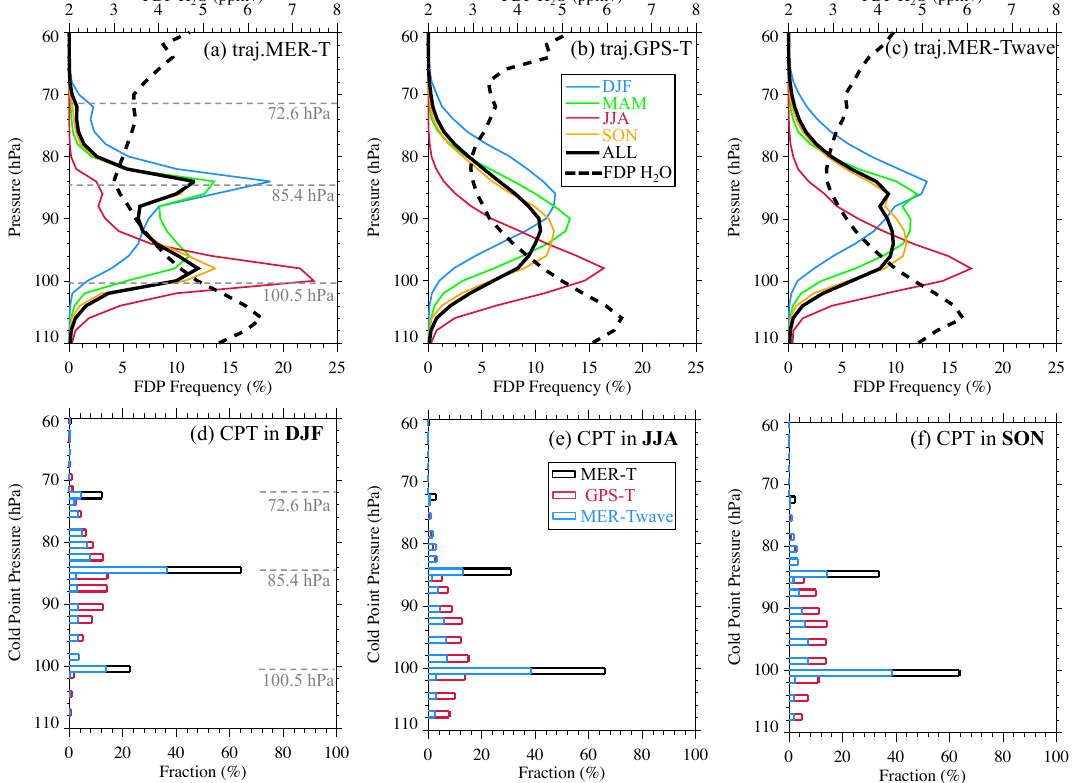
Figure 5. Seasonal FDP vertical distributions (in percentage, first row solid lines, lower x axes) and FDP saturation mixing ratio (FDP H 2 O, i.e., the stratosphere entry-level H 2 O, ppmv, first row dashed lines, upper x axes) from trajectory simulations using (a) MERRA temperatures, (b) GPS temperatures, and MERRA temperatures adjusted by waves (c) , compared to the cold point tropopause (CPT) statistics (second row) during (d) DJF, (e) JJA, and (f) SON. The FDP frequency is normalized by total FDP events, so each solid curve adds up to 100%. The MERRA model levels are marked in (a) and (d) .